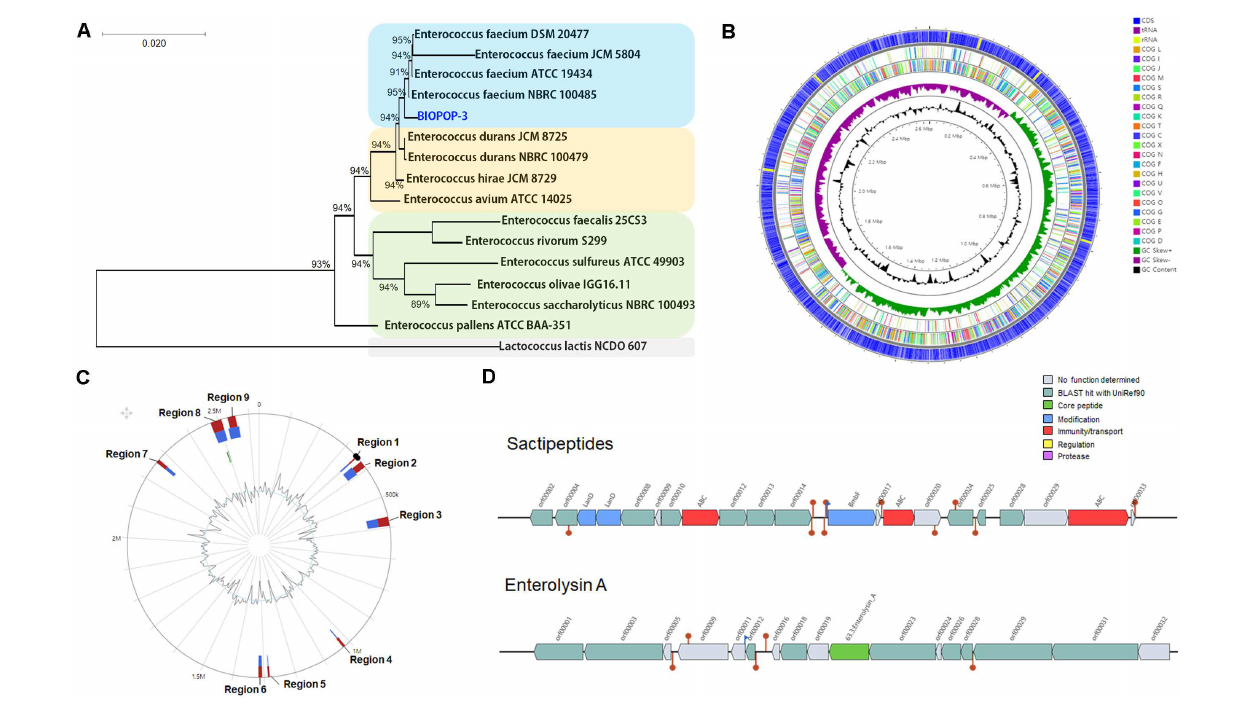
FIGURE 1 | Genomic features of BIOPOP-3 strain. (A) Neighbor-joining tree constructed based on the 16S rRNA sequences. (B) Genomic structure of BIOPIP-3 strain. From outside to inner of the circle: CDS, the distribution of COG functional category, GC skewness, and percentage of GC contents. (C) Predicted nine genomic islands. (D) Predicted bacteriocin-related